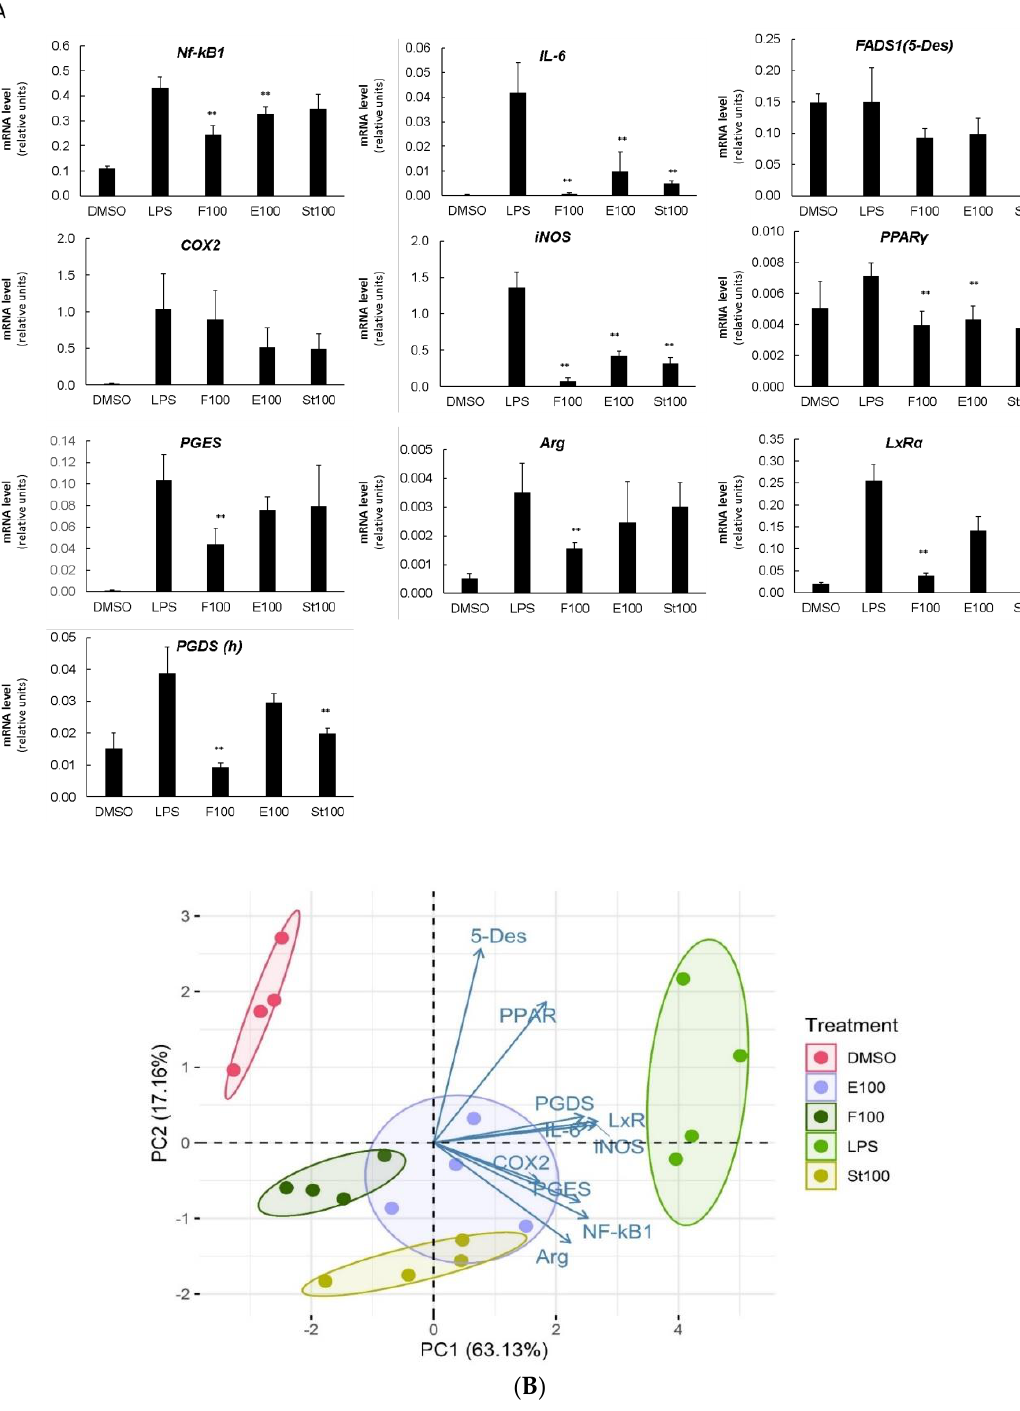
Figure 5. DGLA coordinately modulates the expression of key inflammatory and fatty acid metabolism-related genes in LPS-induced RAW264.7 macrophages. ( A ). Relative normalized expression ( B ). Principal component analysis was performed in R integrated package (four biological replicates are shown as individual circles). Cells were treated as indicated in the legend of Figure 3. mRNA was quantified by quantitative real-time polymerase chain reaction (qRT-PCR). Data are presented as mean ± SD. * and ** denote a significant difference compared to the LPS-induced vehicle control, p < 0.05, and p < 0.001, respectively, n = 4.